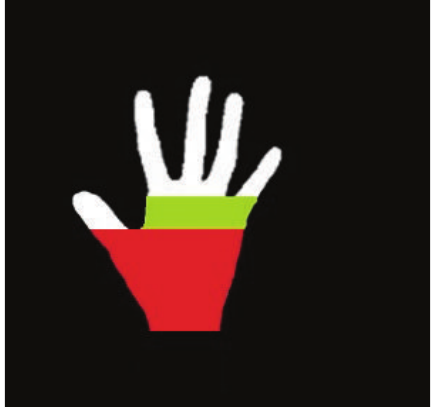
Figure 11: The palm line.